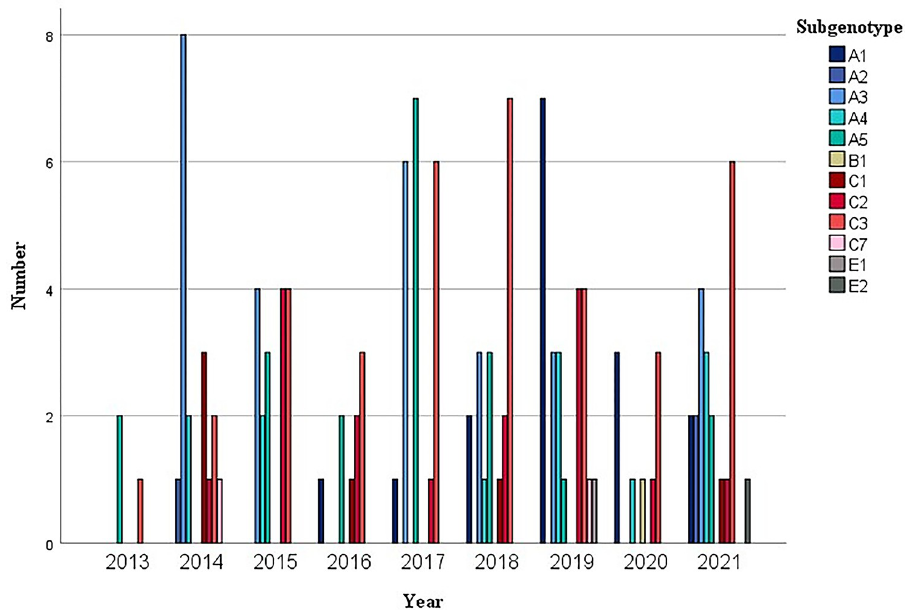
Fig 3. Graphical representation of the temporal distribution of the different HHV-8